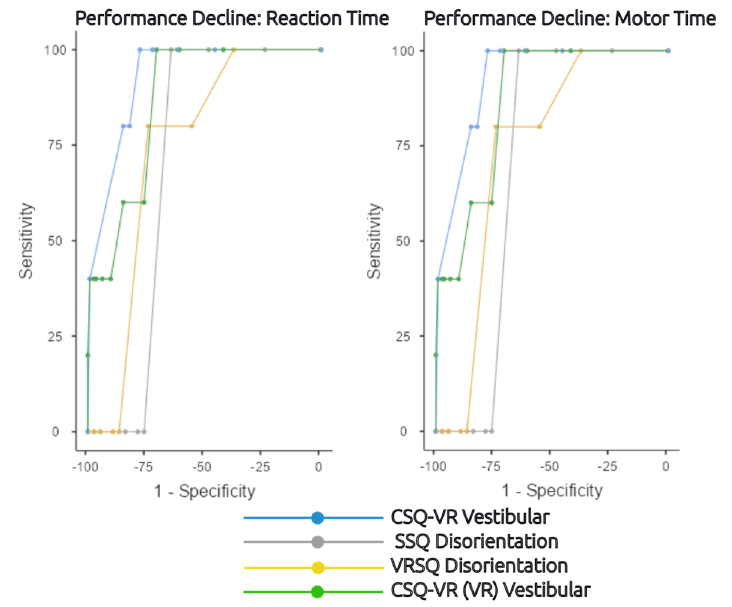
Figure 7. Sensitivity and Specificity of the CSQ-VR, SSQ, and VRSQ Vestibular/Disorientation Scores in detecting Reaction Time ( Left ) and Motor Speed ( Right ) Decline. Note: (VR) = VR ver- sion.